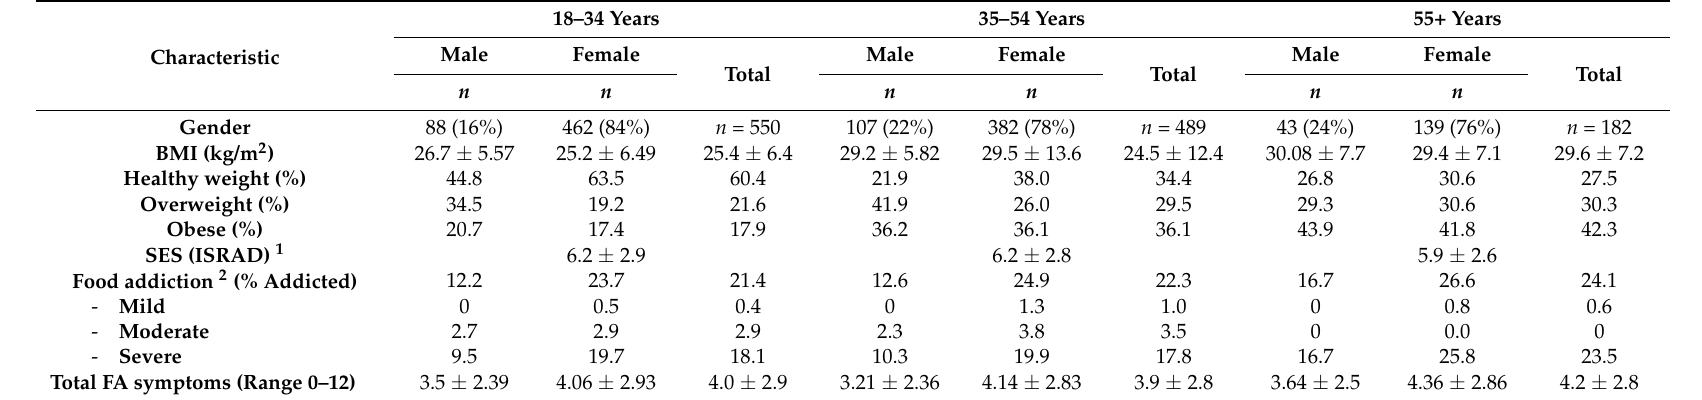
Table 1. Demographics of participants by age